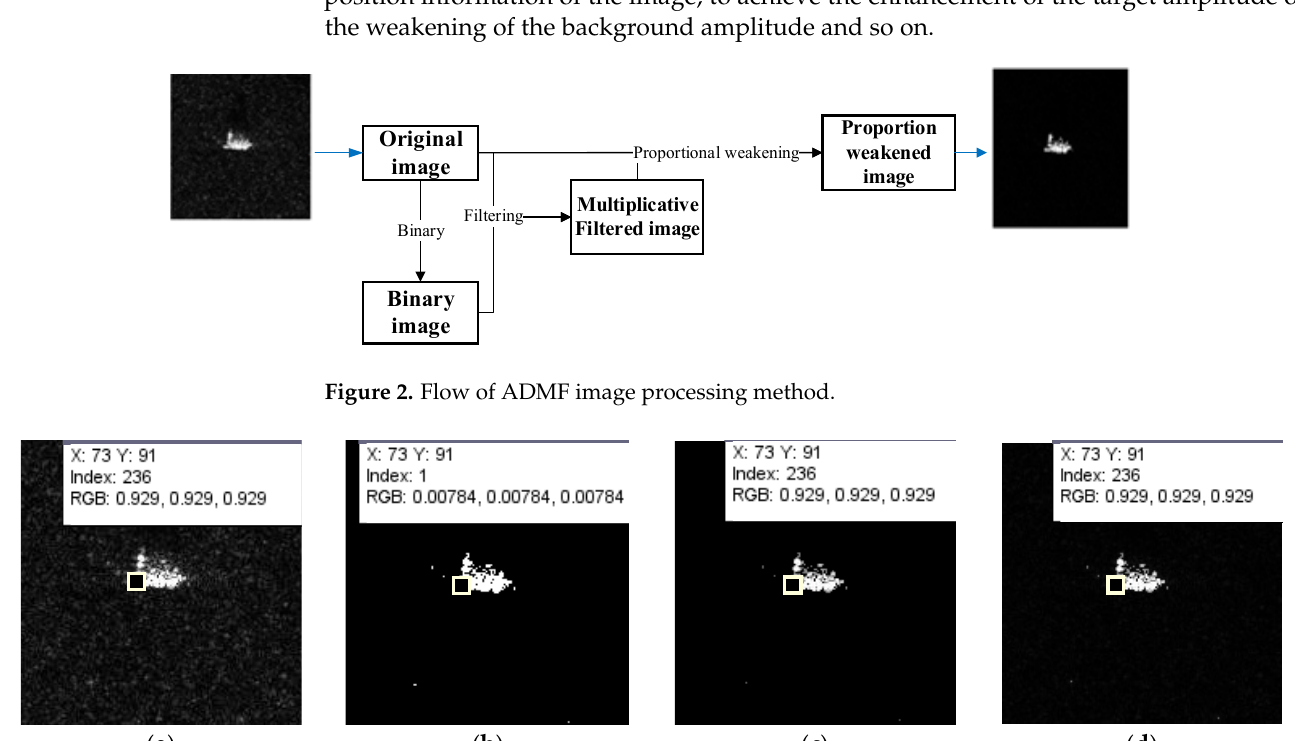
Figure 2. Flow of ADMF image processing method.